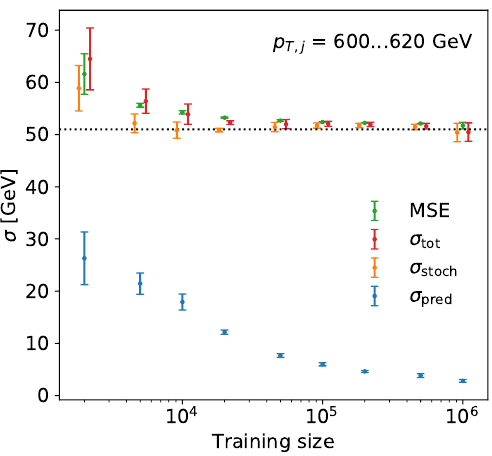
Figure 5: Uncertainty contributions σ training sample. The error bar represents the standard deviation of five different trainings. In addition we include